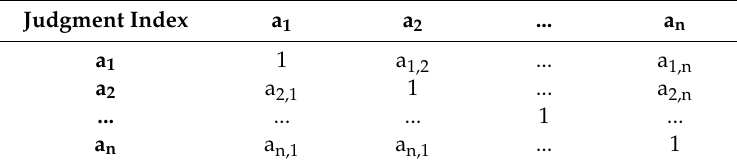
Table 2. Judgment